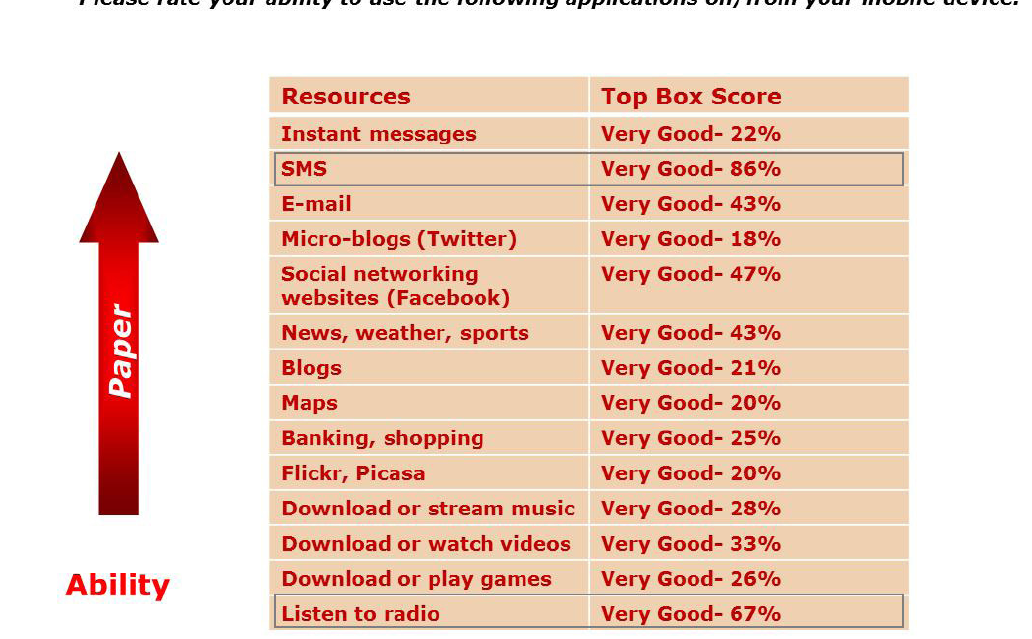
Figure 7. Ability to use applications on/from a mobile device (student